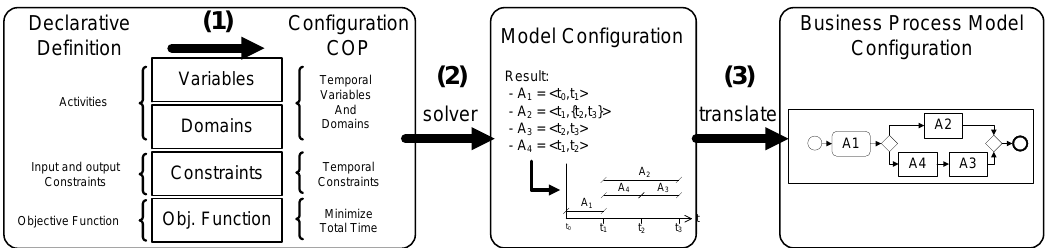
Figure 6. Configuration problem